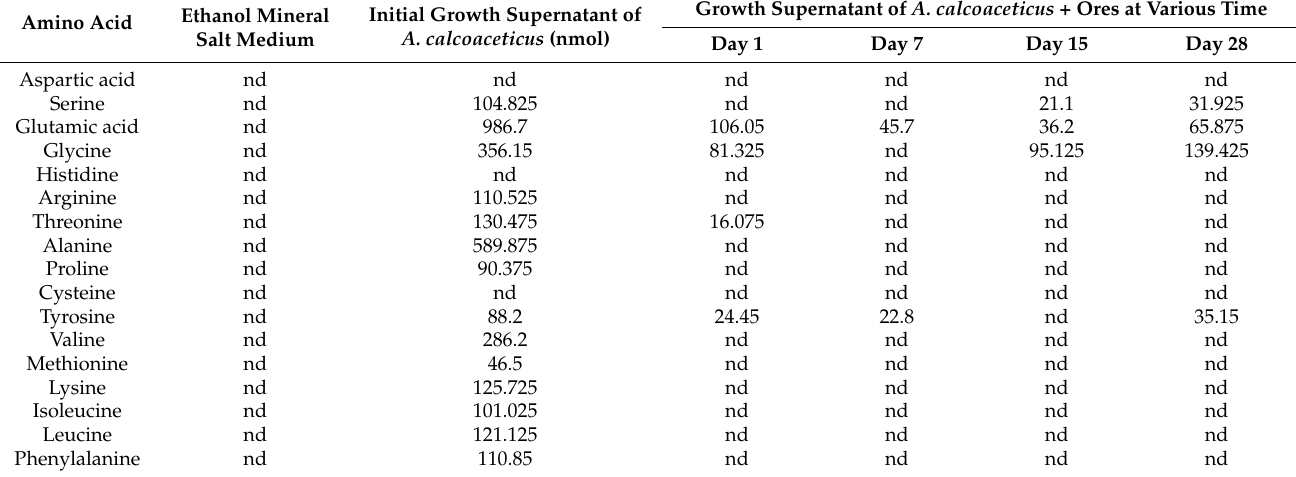
Table 3. Amino acid content of growth supernatant by A. calcoaceticus before and after gold bioleaching. Amino Acid Ethanol Mineral Salt